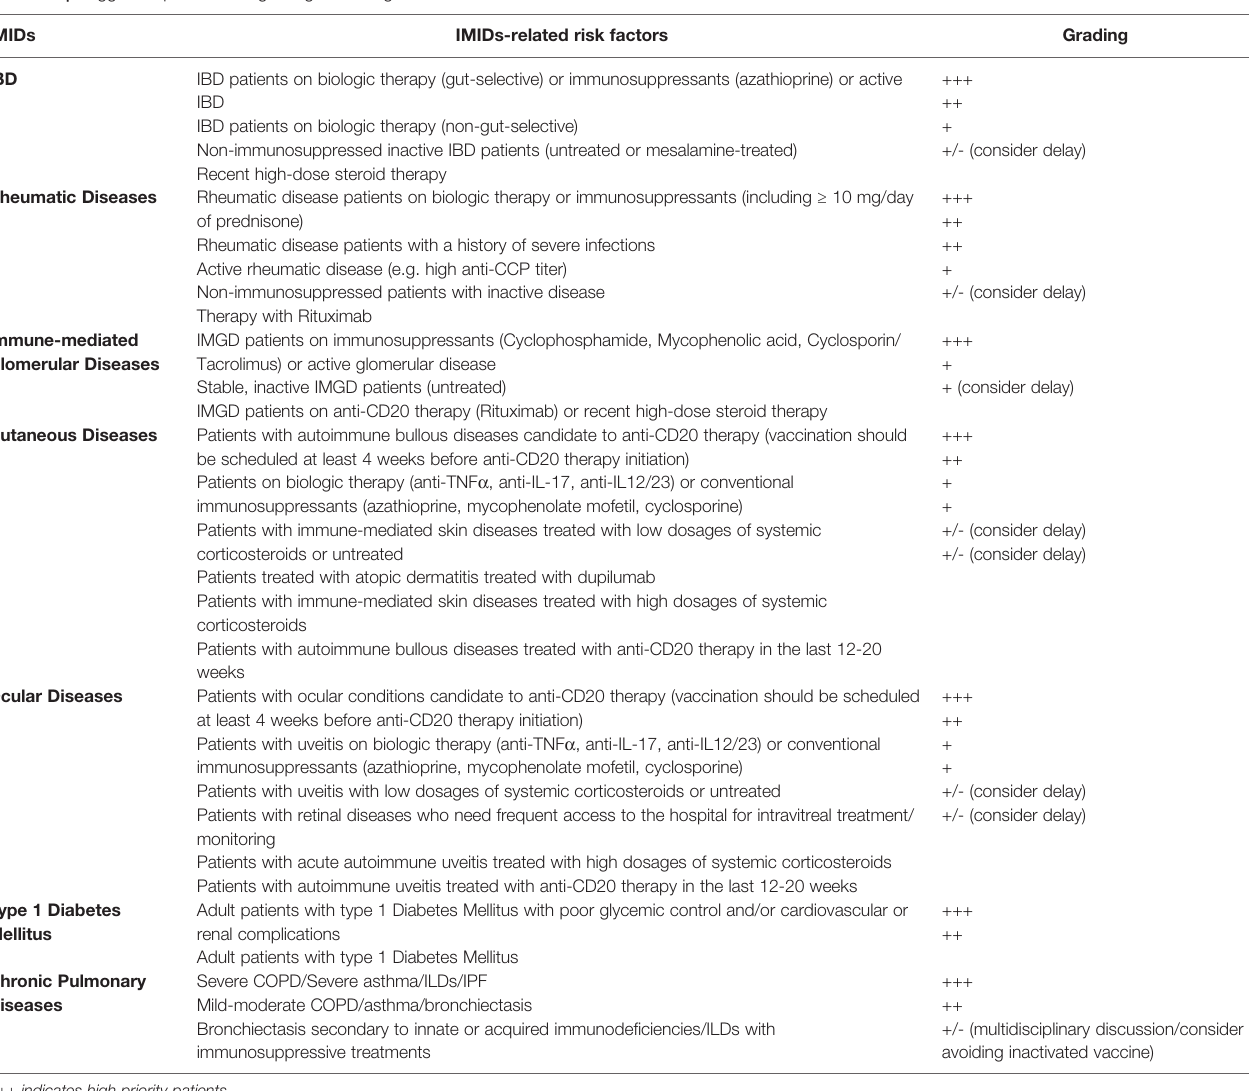
TABLE 2 | Suggested prioritization grading according to IMIDs-related risk factors.